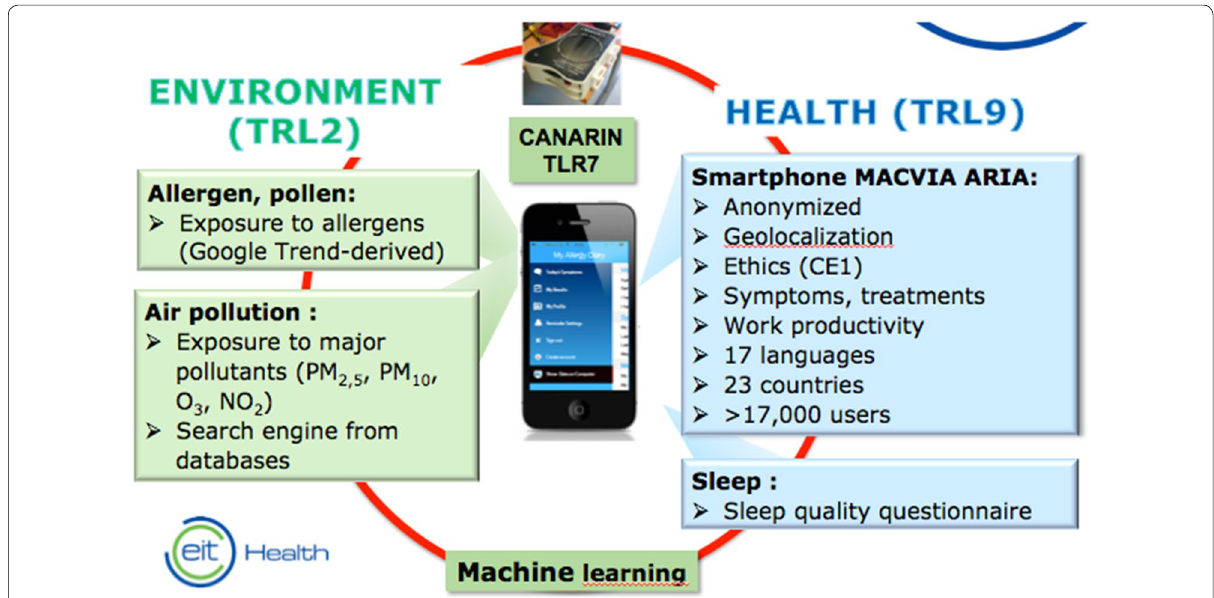
Fig. 3 POLLAR m‑health